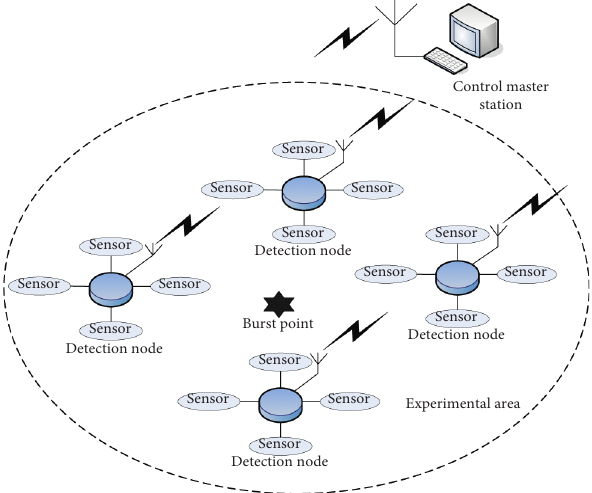
Figure 1: Schematic diagram of shallow underground distributed source